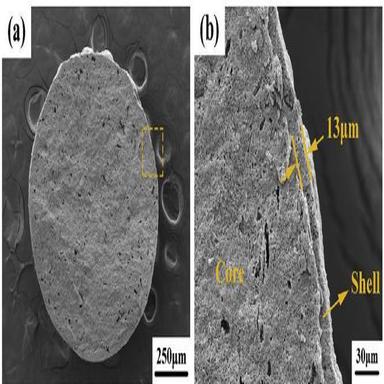
SEM morphology of the cross-section of Li4TiO4-Li2TiO3 core-shell ceramic pebbles prepared by a chitosan-assisted rolling coating method and sintered at 750 -C.